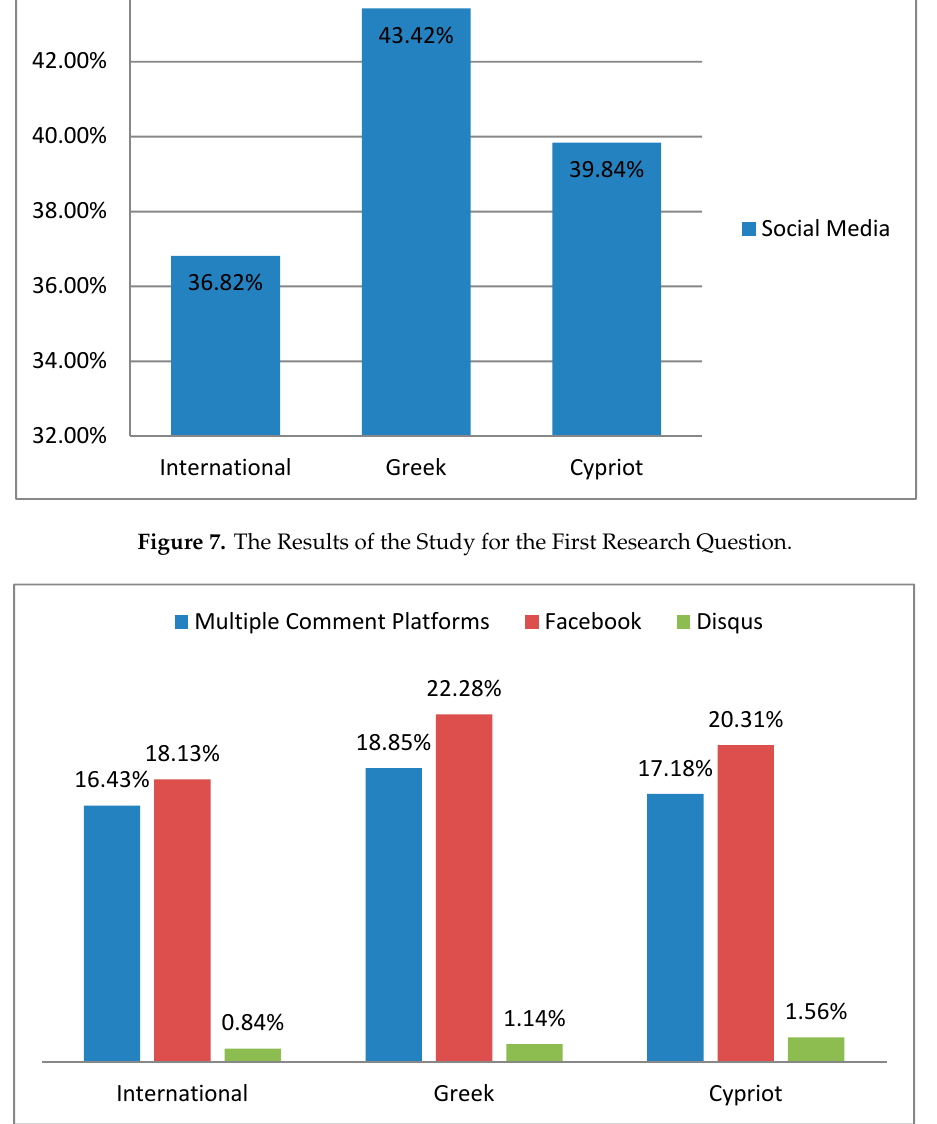
Figure 8. The Results of the Study for the Second Research Question.